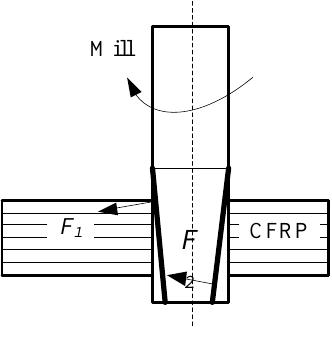
Figure 4. Force analysis of the staggered PCD end mill.